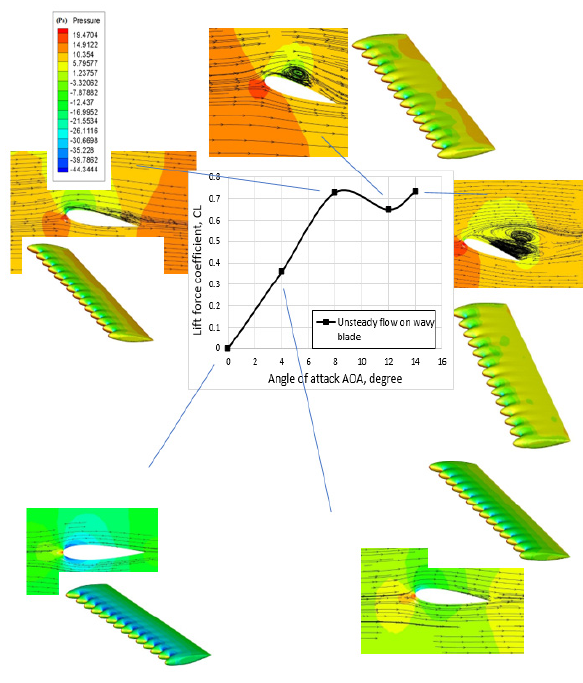
Figure 11. A contour plot showing the streamlines for different angles of attack at wavy blade.